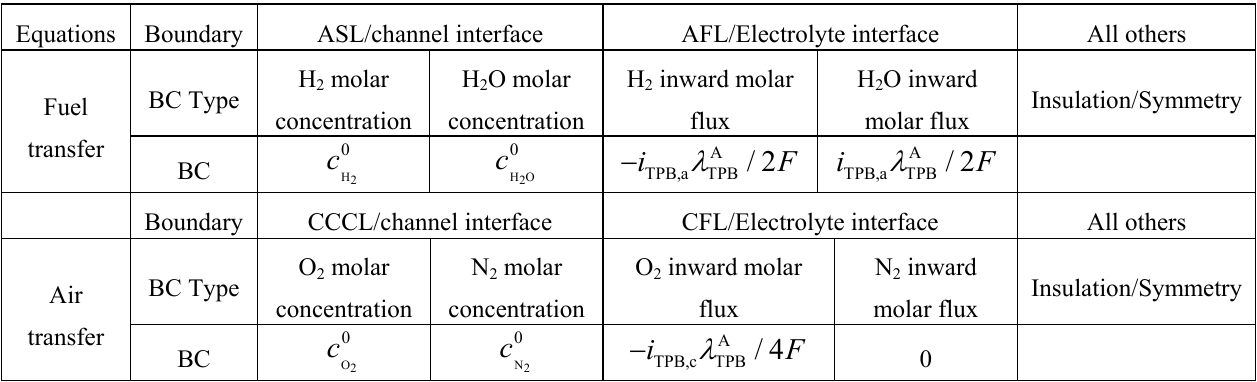
Table 2. Boundary settings for mass transports in electrodes.